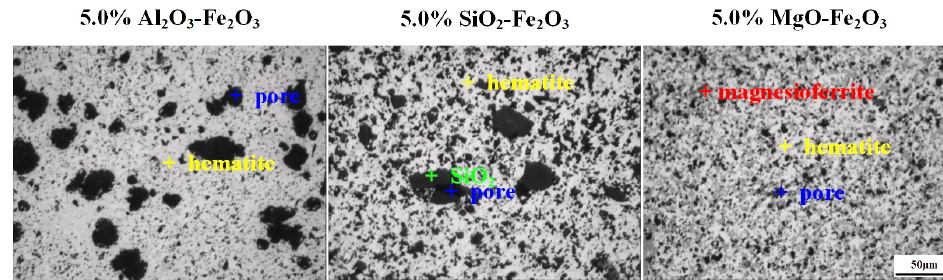
Figure 3. Micrographs of the preheated samples with different gangue component.